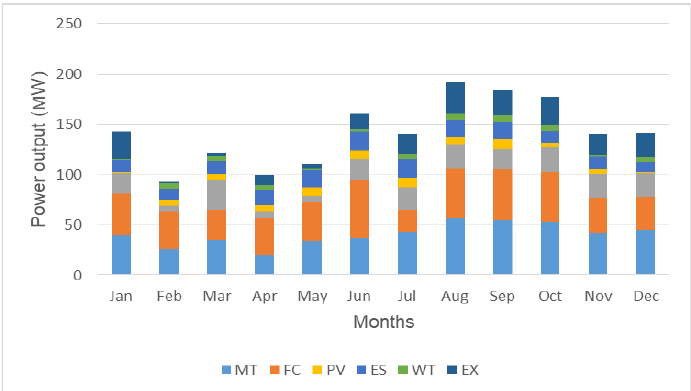
Figure 12. The microgrid ’ s typical year recourse load outputs.